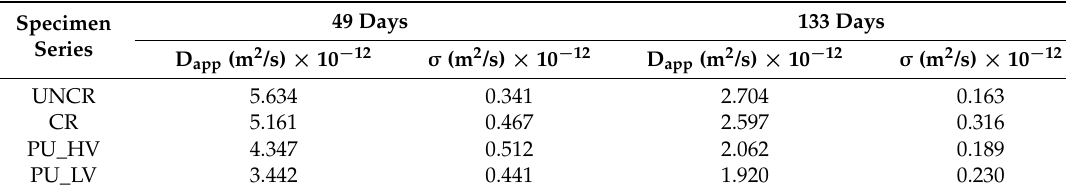
Table 6. Estimated values of D app for the different test series at both exposure